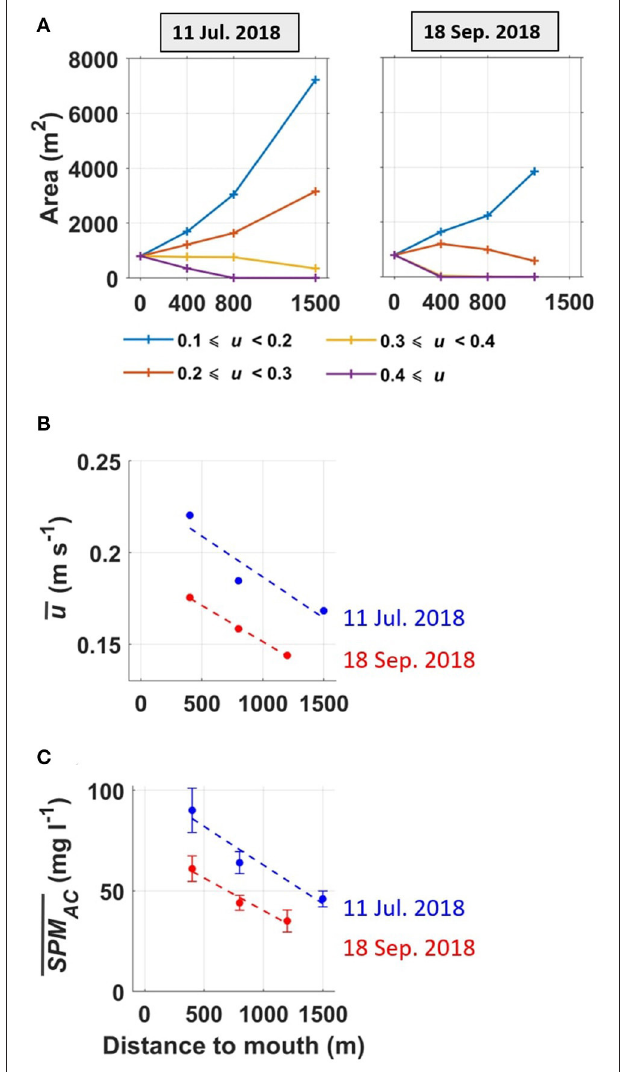
FIGURE 7 | (A) Areas in the interflow covered by different classes of normal current velocities, (B) mean interflow normal velocity, and (C) mean SPM as function of distance from the Rhône River mouth, averaged over the full interflow area for the two field campaigns. The legend in (A) defines the velocity